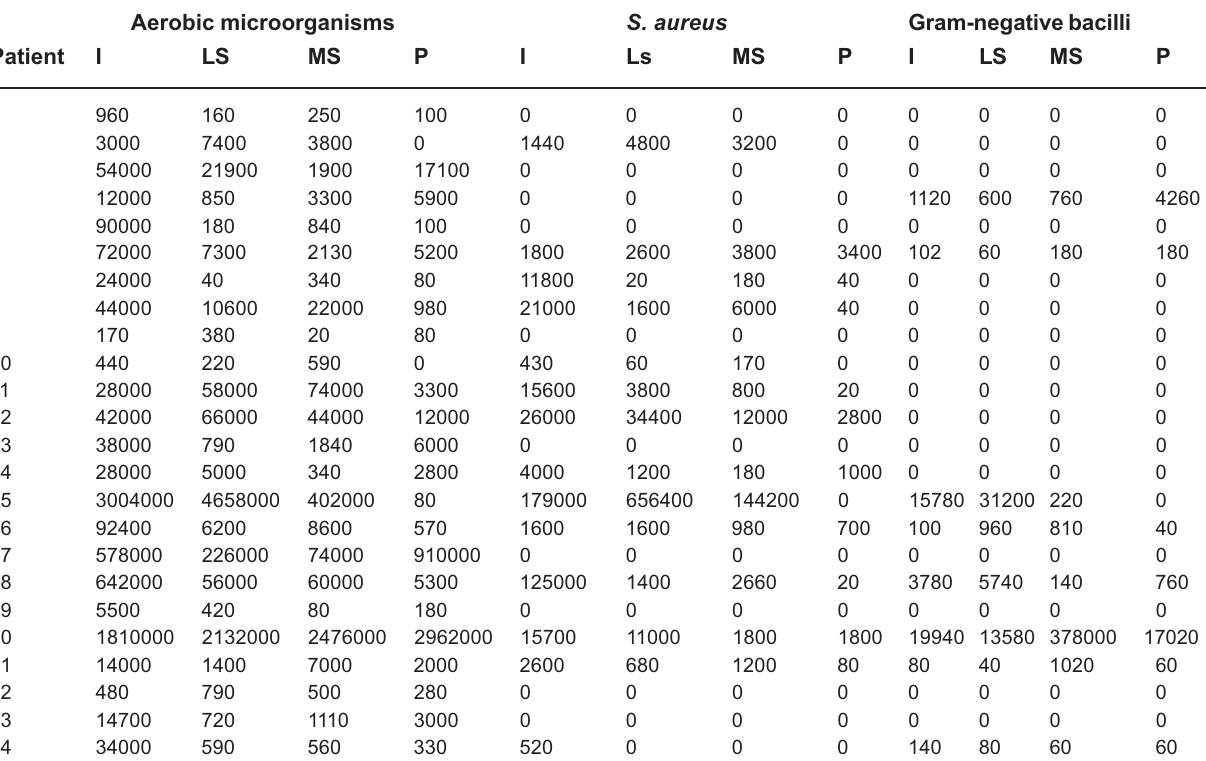
TABLE 1- Cfu counting for aerobic microorganisms, S. aureus and gram negative bacilli on the ocular prosthesis